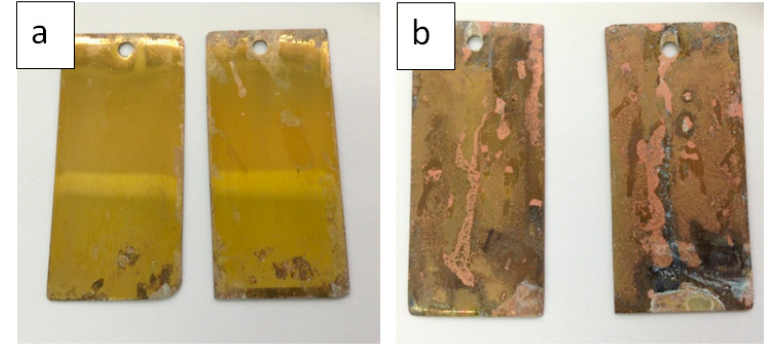
Figure 12. Brass samples after 5 days of salt spray corrosion test: ( a ) sample treated with MBT; ( b ) sample treated with MNBI.